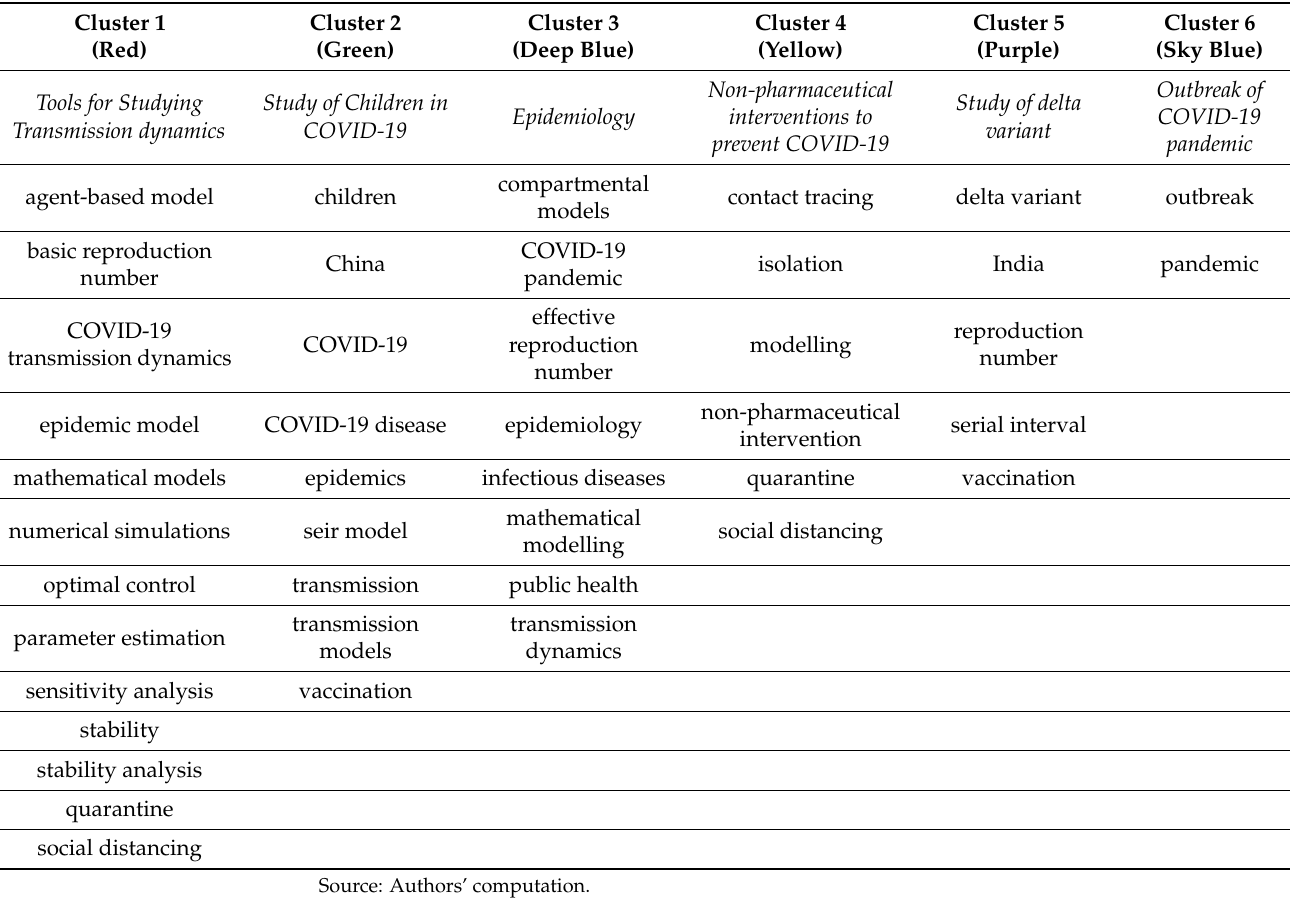
Table 6. Keyword Co-occurrence